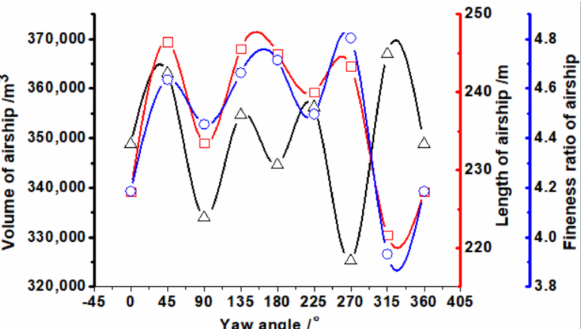
Figure 16. The optimized volume, length, and fineness ratio of airships for different heading